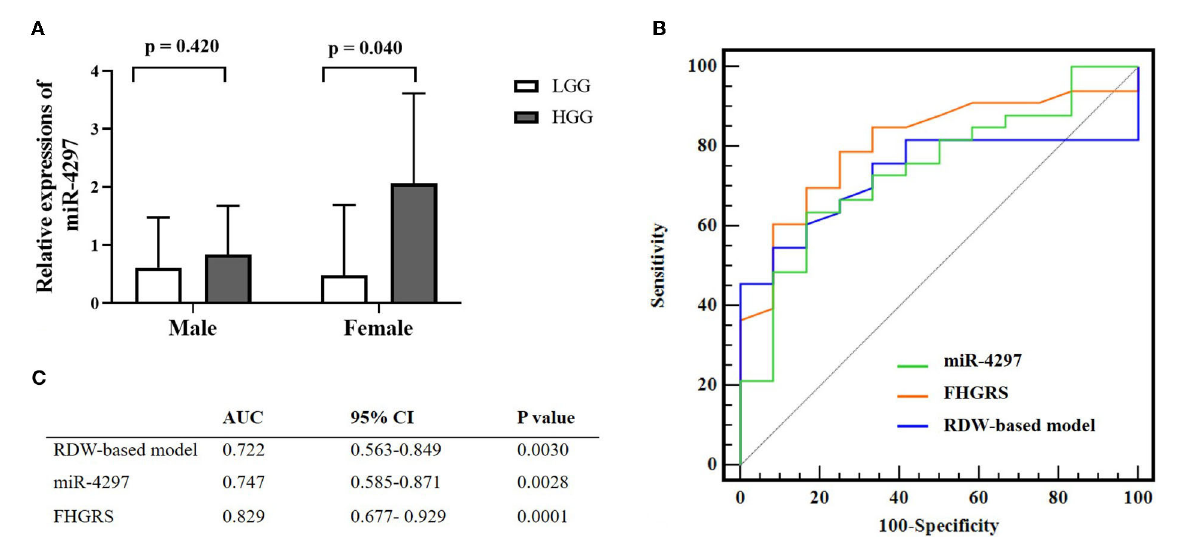
FIGURE3 Pre-operative non-invasive biomarkers for female HGGs patients. (A) Sex-specific miR-4297 levels between LGGs and HGGs; (B) Comparison of miR-4297, FHGRS, and RDW-model for predicting HGGs in female patients by AU-ROC analysis. (C) AU-ROC values of RDW-based model, miR-4297 and FHGRS. LGGs , low-grade gliomas; HGGs , high-grade gliomas; AU-ROC , the areas under the receiver operating characteristic curves.